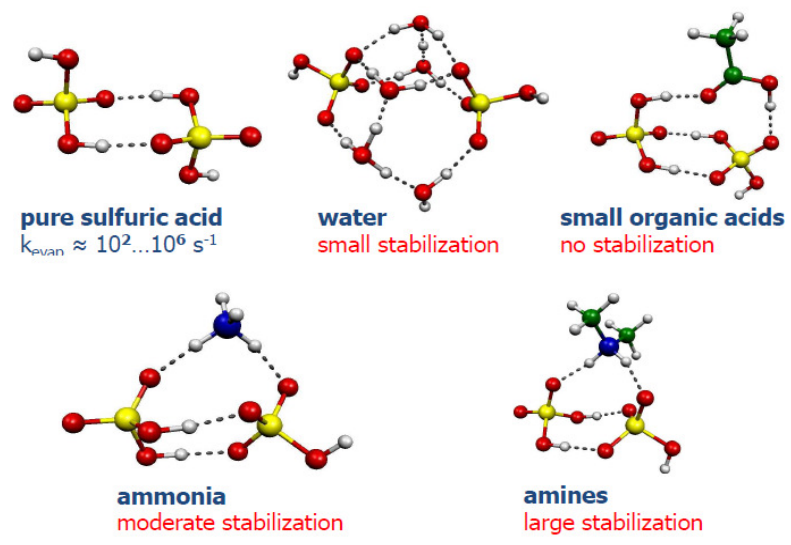
Fig. 8. Relative stability of sulfuric acid clusters with different stabilizing compounds (water, organic acids, ammonia and dimethyl amine) based on the evaporation rates k evap calculated with quantum chemistry. The atoms are color-coded as follows: yellow – sulfur, red – oxygen, grey – hydrogen, blue – nitrogen and green – carbon. Dashed lines depict hydrogen bonds.